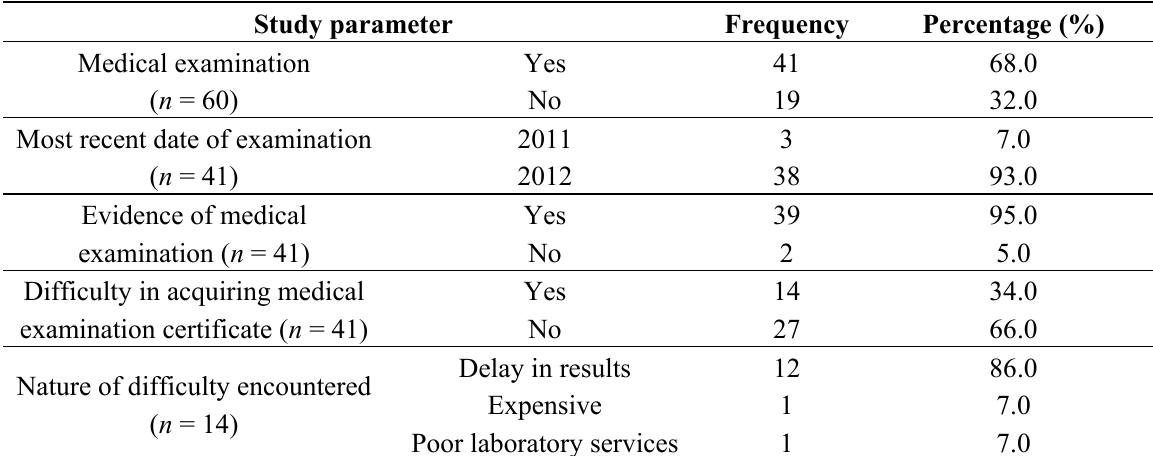
Table 3. Information on medical screening of